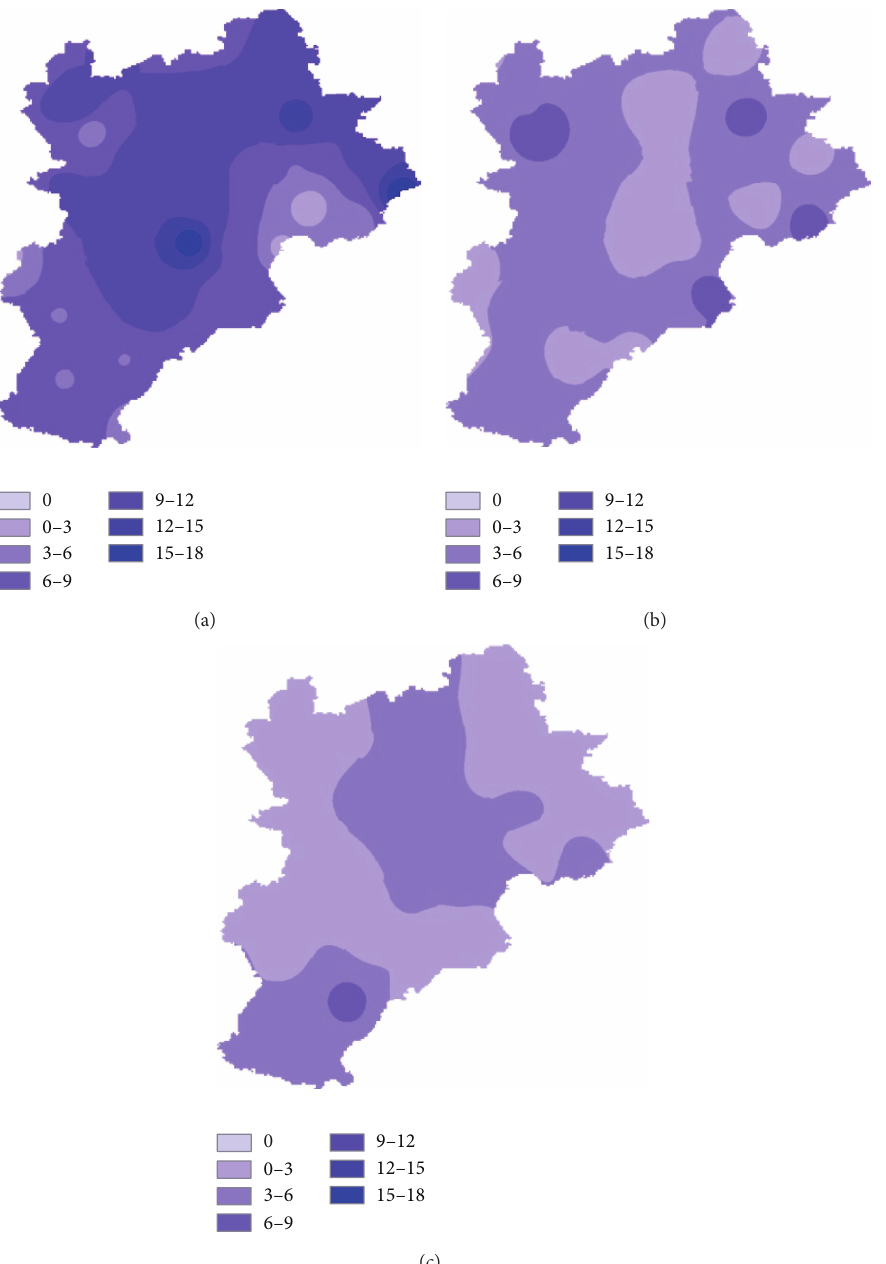
Figure 12: Spatial distribution of the frequency (in percent) of the RDI-12 values related to the following categories: (a) moderate, (b) severe, and (c) extreme